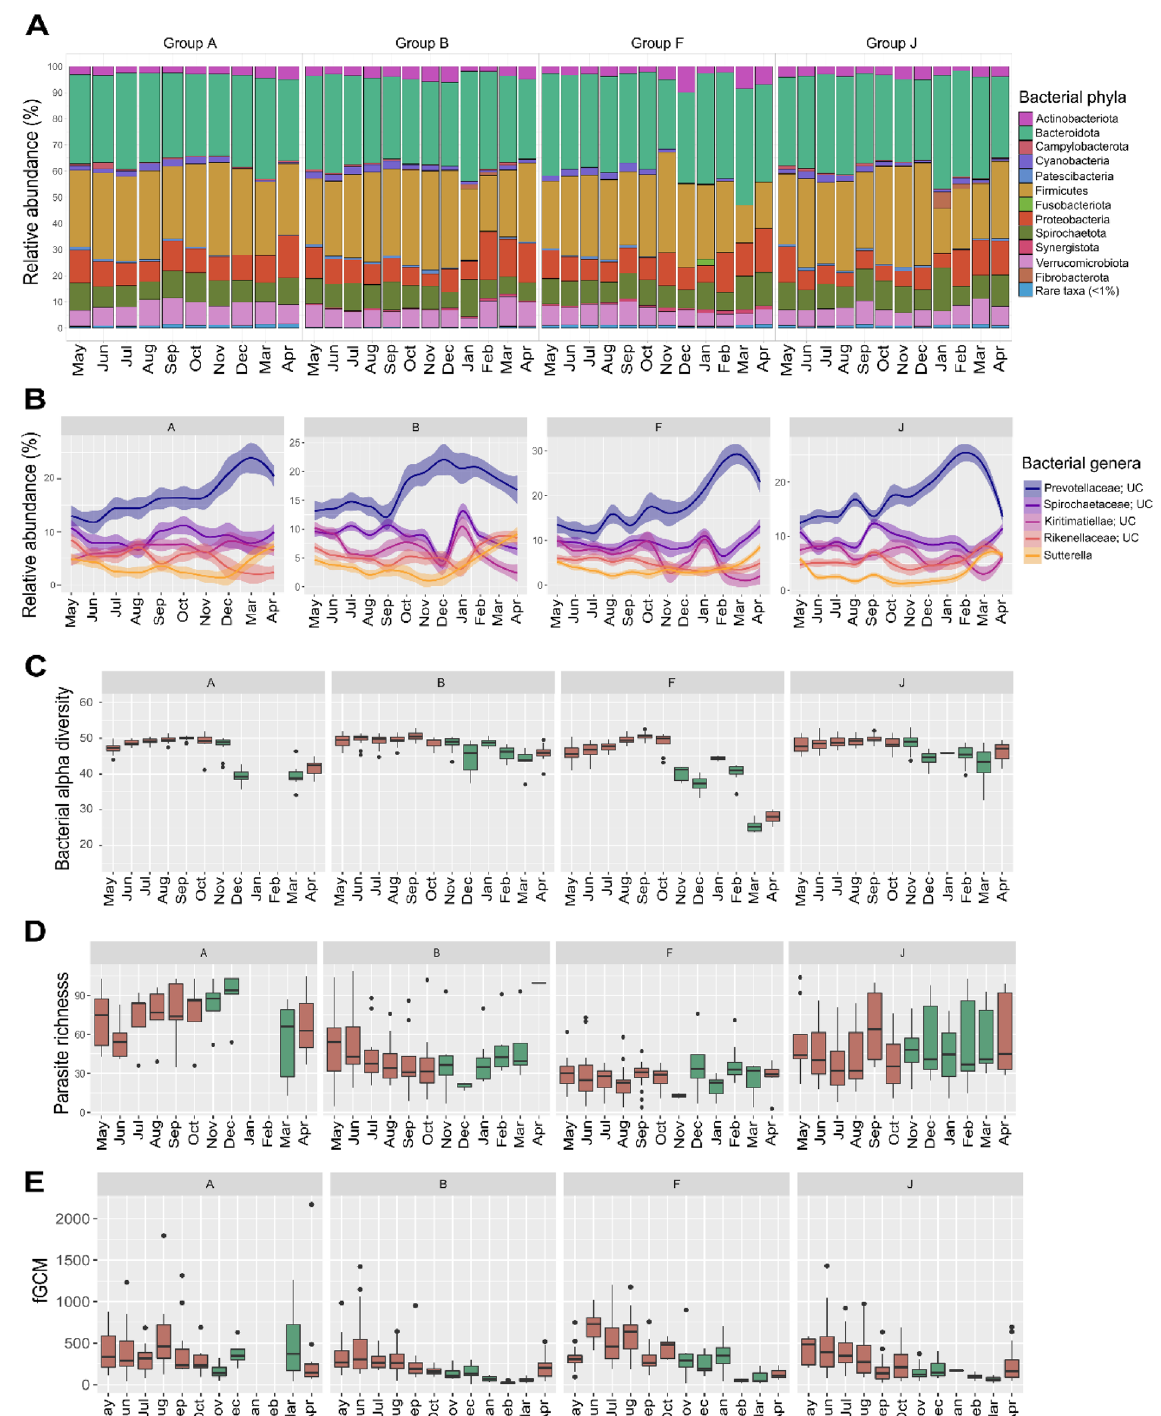
Figure 1. Overview of the monthly fluctuations of bacterial communities, bacterial alpha diversity, eukaryote parasite richness and fGCM concentrations for each lemur group. Box plots are color coded to indicate the dry (brown) and rainy (green) season. ( A ) Monthly averaged relative abundances of bacterial phyla per group. ( B ) Top 5 most abundant bacterial genera and their monthly changes. ( C ) Monthly variations in alpha diversity measured as Faith’s Phylogenetic Diversity Index. ( D ) Monthly changes in parasite richness. ( E ) Concentrations of fGCM measured as ng/g of wet feces aggregated per